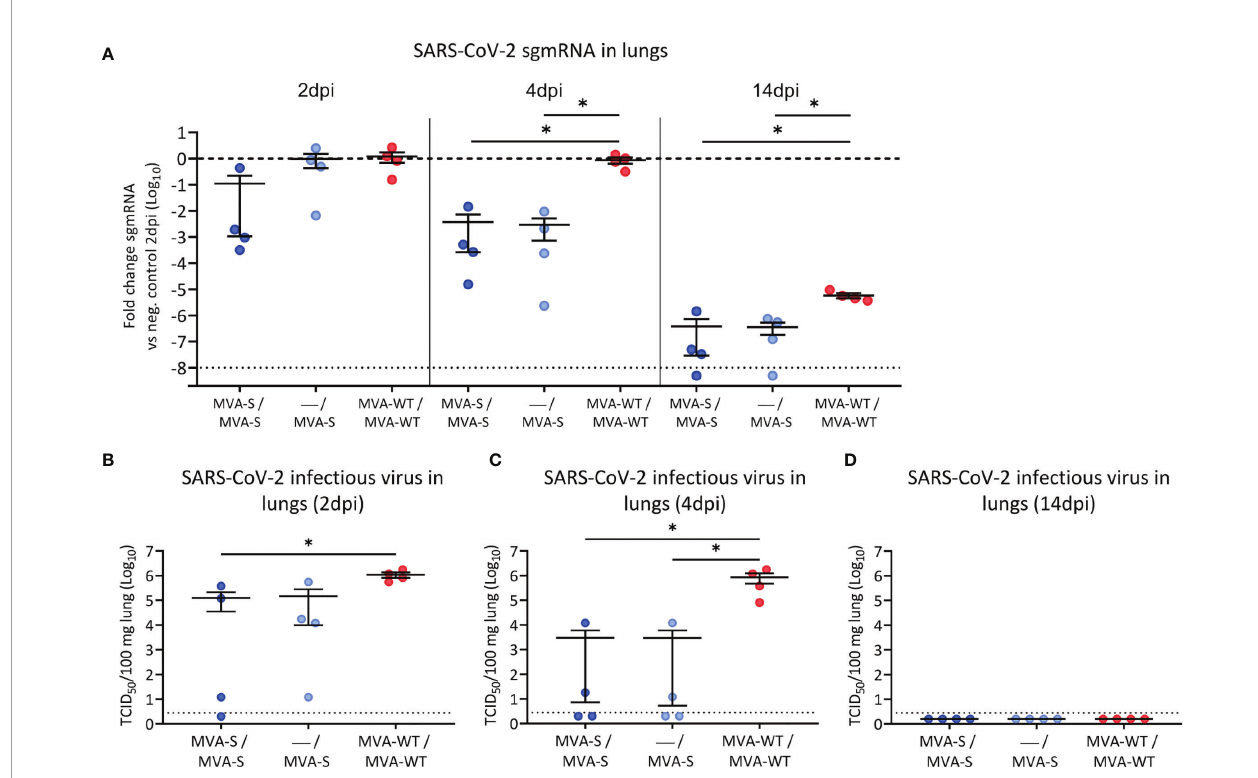
FIGURE 2 | SARS-CoV-2 virus replication in lung samples. SARS-CoV-2 sgmRNA levels (A) and infectious viral loads (B – D) in lungs of vaccinated hamsters. (A) SARS-CoV-2 sgmRNA levels were normalized against levels of b -actin, and fold changes compared to the MVA-WT control group of day 2 post-infection were calculated using the 2 - DD Cq method. Dashed line indicates the mean of the control group. (B – D) Infectious viral loads in lungs of hamsters on day 2 (B) , day 4 (C) , and day 14 (D) post-infection are expressed as the number of infectious virus particles per 100 mg of lung tissue. Dotted line indicates the limit of detection. Data presented as means ± SEM. Statistical signi fi cance between groups was calculated by Mann – Whitney test (*p <